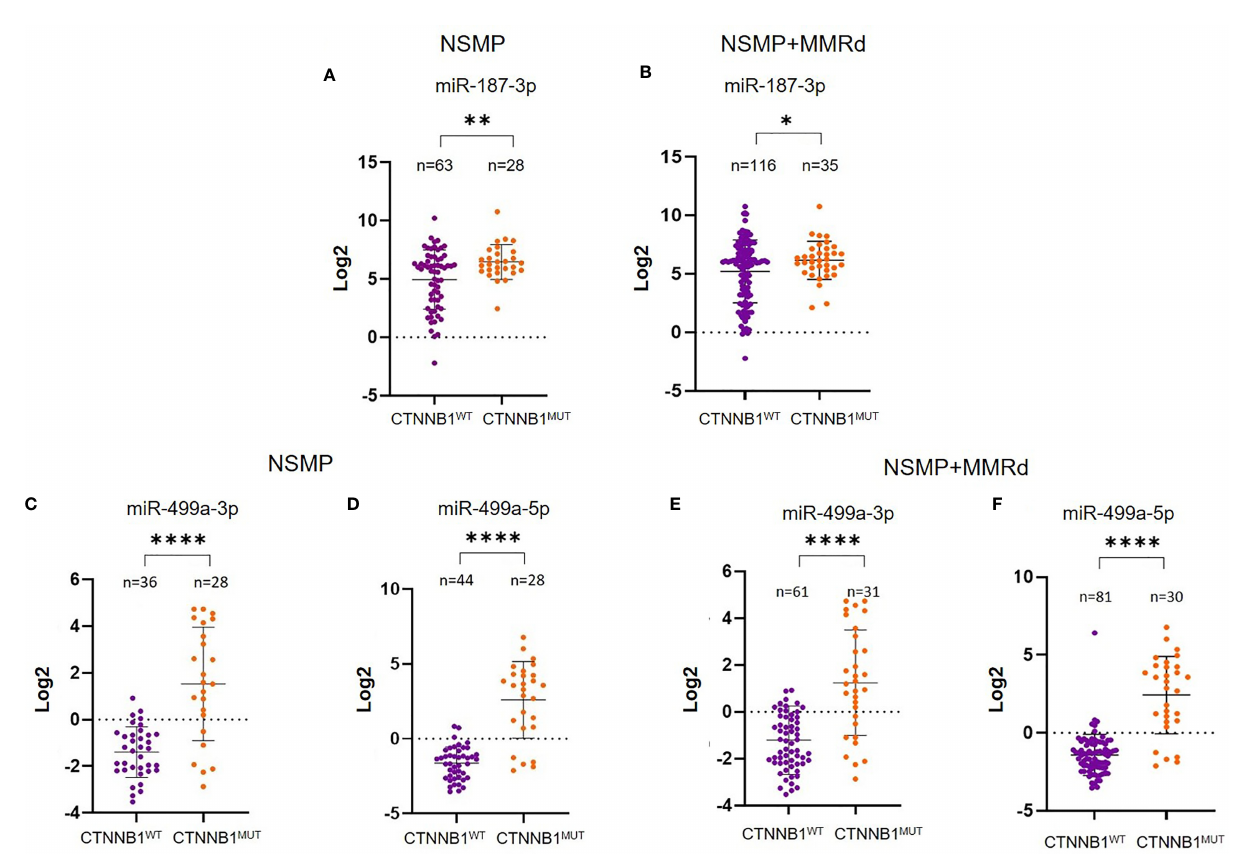
FIGURE 2 | Analysis of miR-187-3p in the NSMP alone and in NSMP + MMRd TCGA cohorts (A, B) . Analysis of miR-499a-3p and miR-499a-5p in the TCGA NSMP alone (C, D) and in NSMP + MMRd EC groups (E, F) . *p < 0.05; **p < 0.01; ****p <